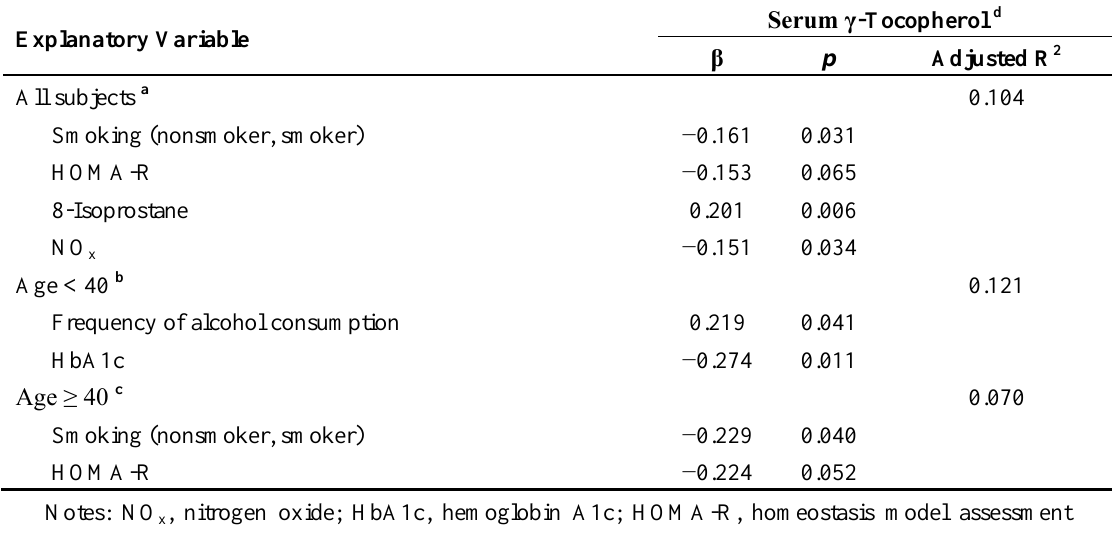
Table 6. Multiple regression analysis of serum γ-tocopherol with each parameter. Explanatory